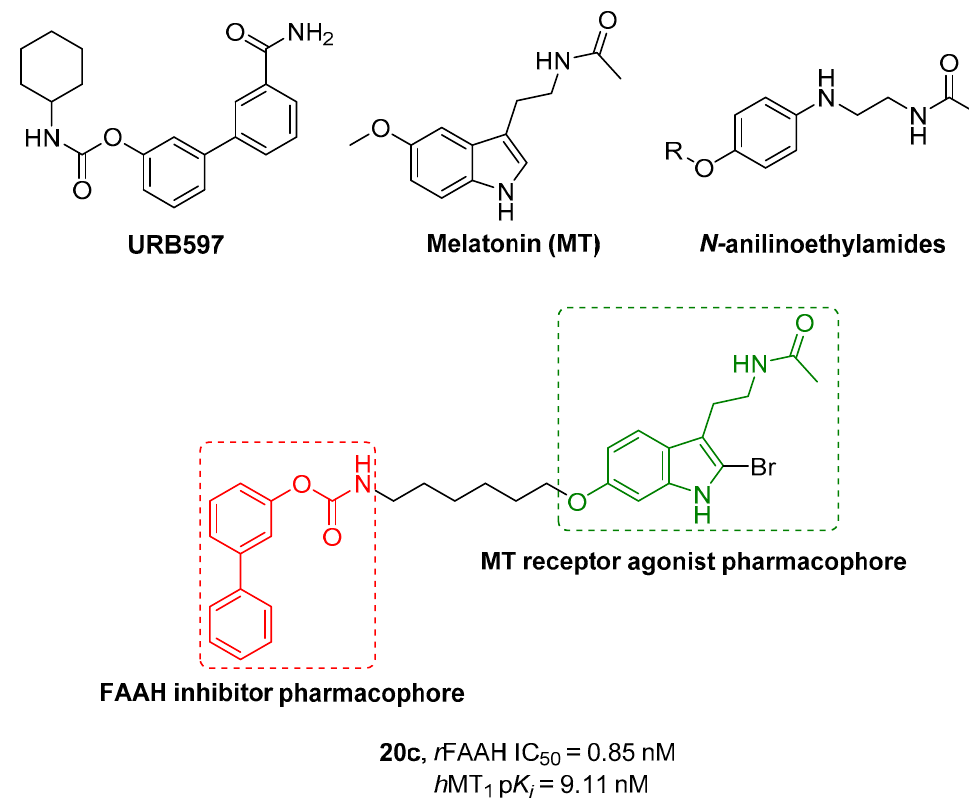
Figure 6. Chemical structures of FAAH and Melatonin receptor ligands.